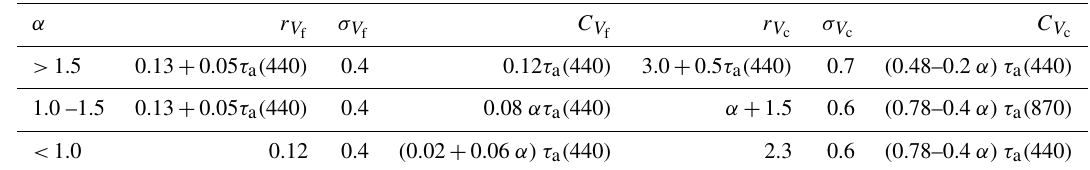
Table 4. Initial guesses used as defaults for the GRASP-AOD retrieval. The values, as can be seen in the table, are given as a function of Ångström exponent and the aerosol optical depth at 440nm.